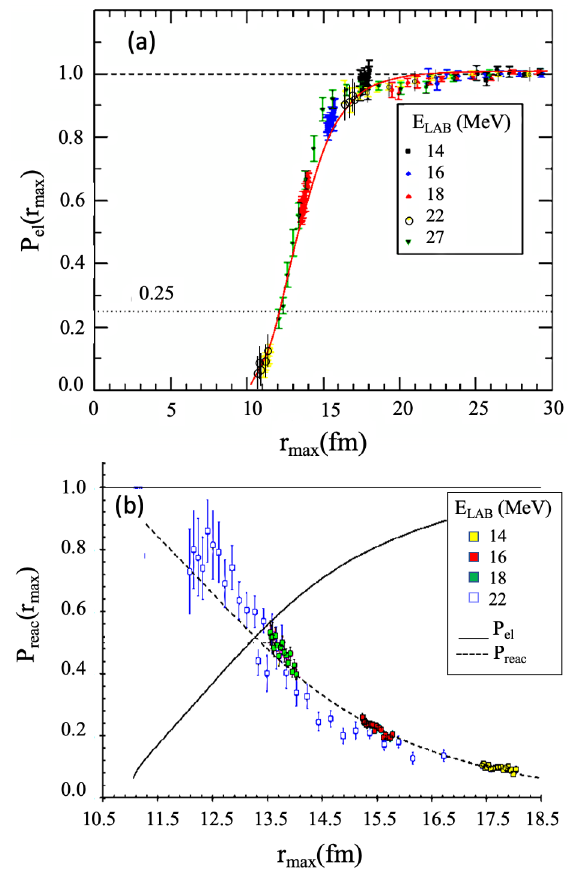
Fig. 4. (a) Ratio of the elastic cross sections over Rutherford Pel(r max ), as a function of the distance of closest approach in a Coulomb trajectory for the reaction 6 He+ 208 Pb. (b) Same as before for the ratio of the cross section for alpha production over Rutherford, P reac (r max